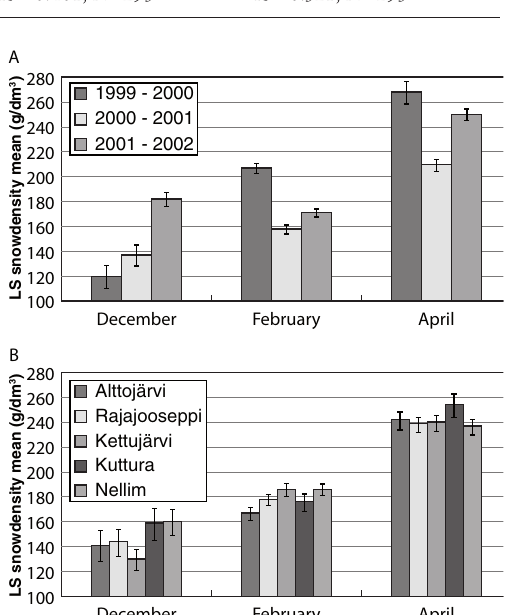
Fig. 5. Snow density (g/dm 3 , LS (Least Squares) mean ± SE (Standard Error)) a) in different months and b) in different measurement areas during winters 1999 - 2002 in the Ivalo reindeer herding